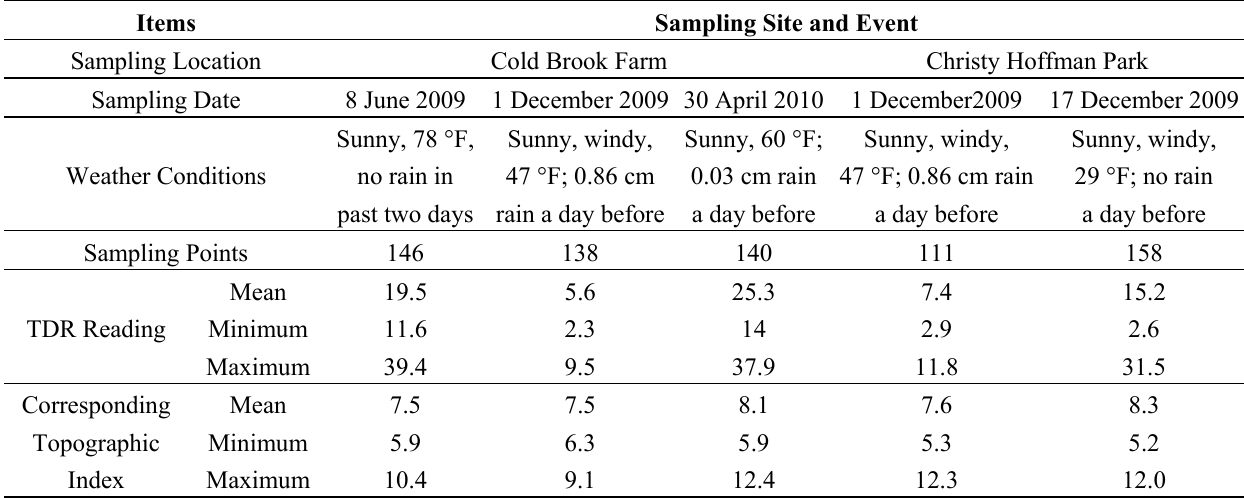
Table 1 . Soil moisture measurements in two fields in Tewksbury